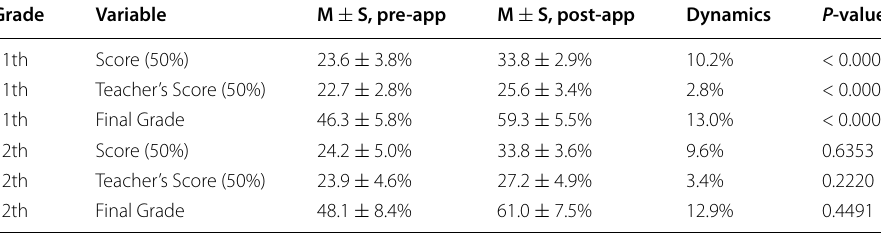
Table 2 Relative dynamics of the post-app period to the pre-app period in each grade